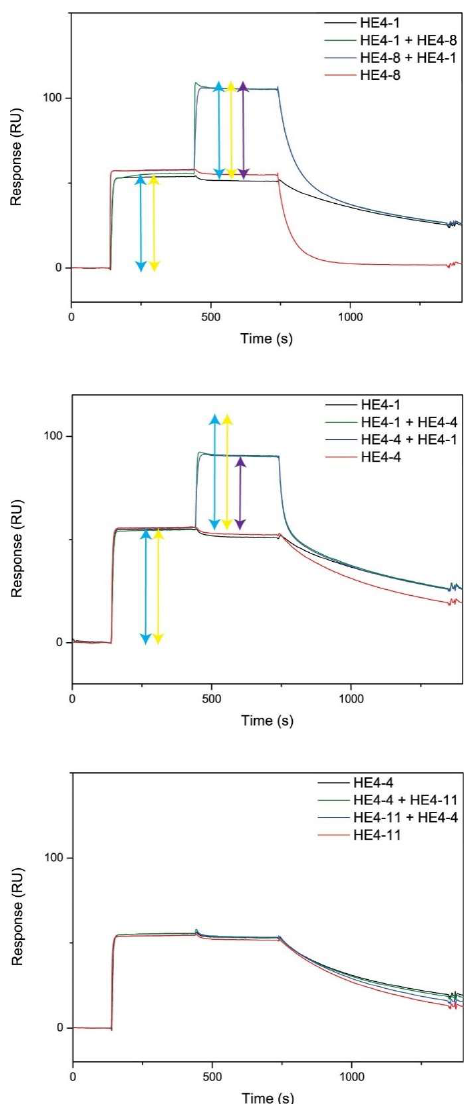
Figure 3. Competition in the antigen binding of HE4 Nbs as determined by epitope mapping. HE4-1 with HE4-8 (not competitive, top ), HE4-1 with HE4-4 (partially competitive, middle ), and HE4-4 with HE4-11 (competitive, bottom ).